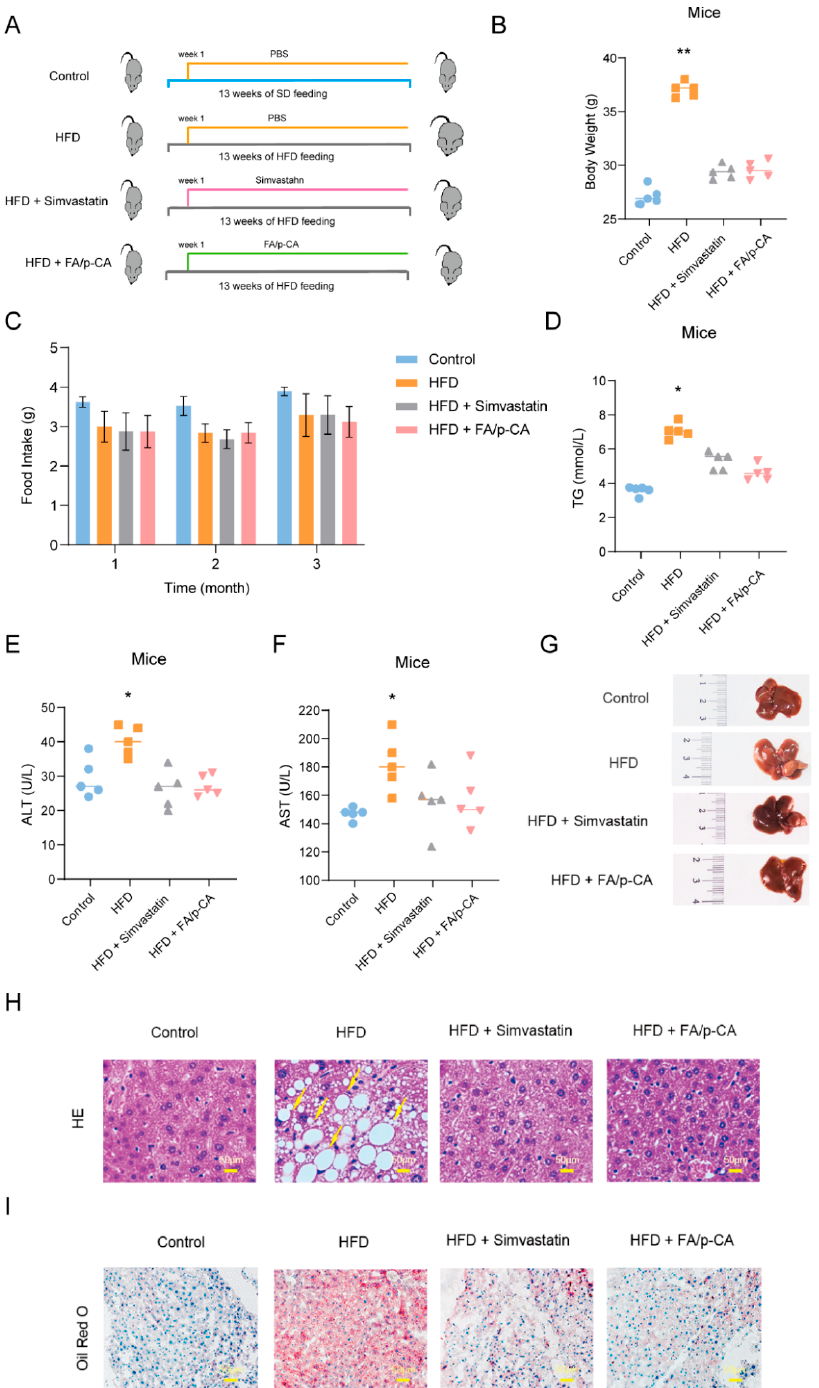
Figure 3. FA/p-CA attenuate HFD-induced hepatic injury and steatosis in vivo. ( A ) An overview of the experimental design of HFD-induced NAFLD mice model. FA/p-CA was administered by gavage and the content ratio of p-CA and FA in the FA/p-CA was 1:1.13. ( B ) Body weight. ( C ) Food intake. ( D ) Serum total TG. ( E ) Serum ALT. ( F ) Serum AST. ( G ) Macroscopic structure of the liver. ( H , I ) Representative images of H&E ( H ) and Oil Red O ( I ) staining at 40 × magnification. Yellow arrows are used to mark steatosis and hepatocyte ballooning. Compared to control, * p < 0.05, ** p <